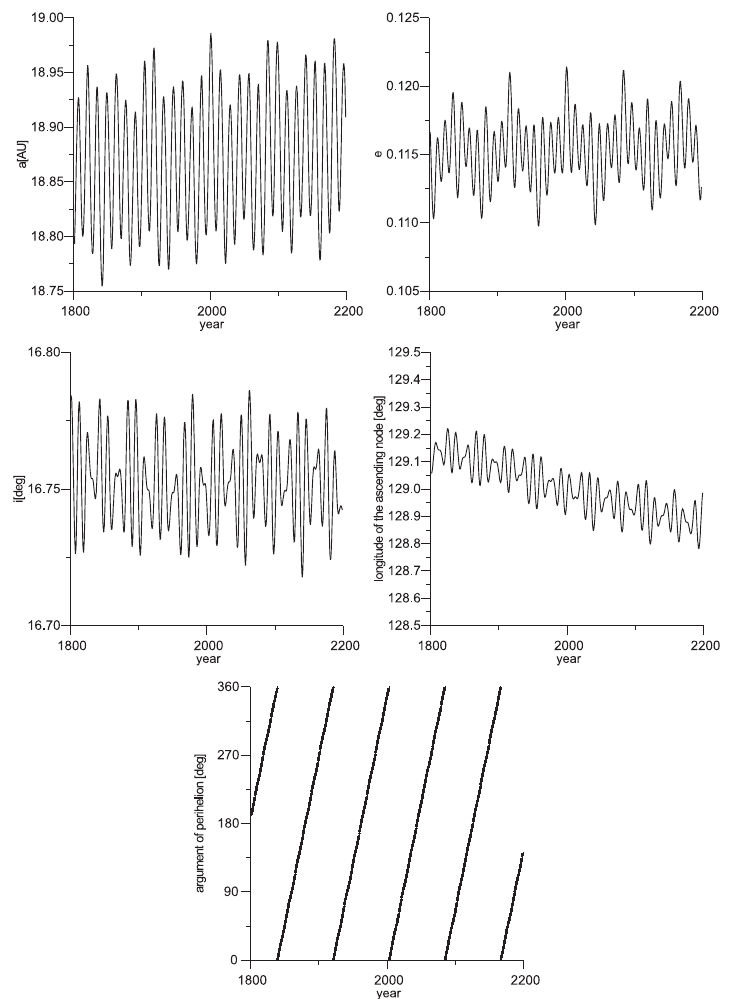
Fig. 5. Time evolution of the orbital elements of 2012 DS85 between 1800 and